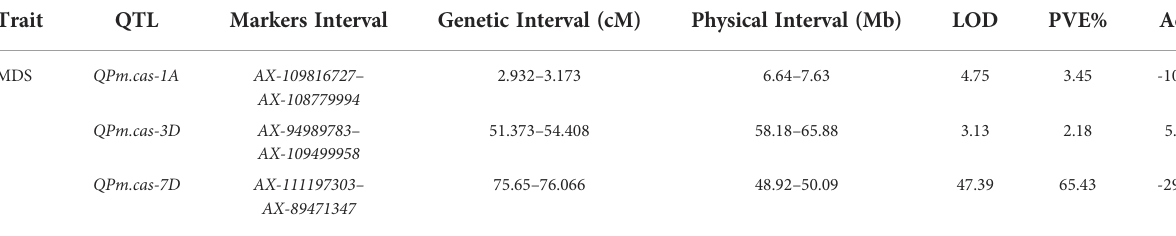
TABLE 2 QTLs for maximum disease severities (MDS) in the PG-RIL population. Trait QTL Markers